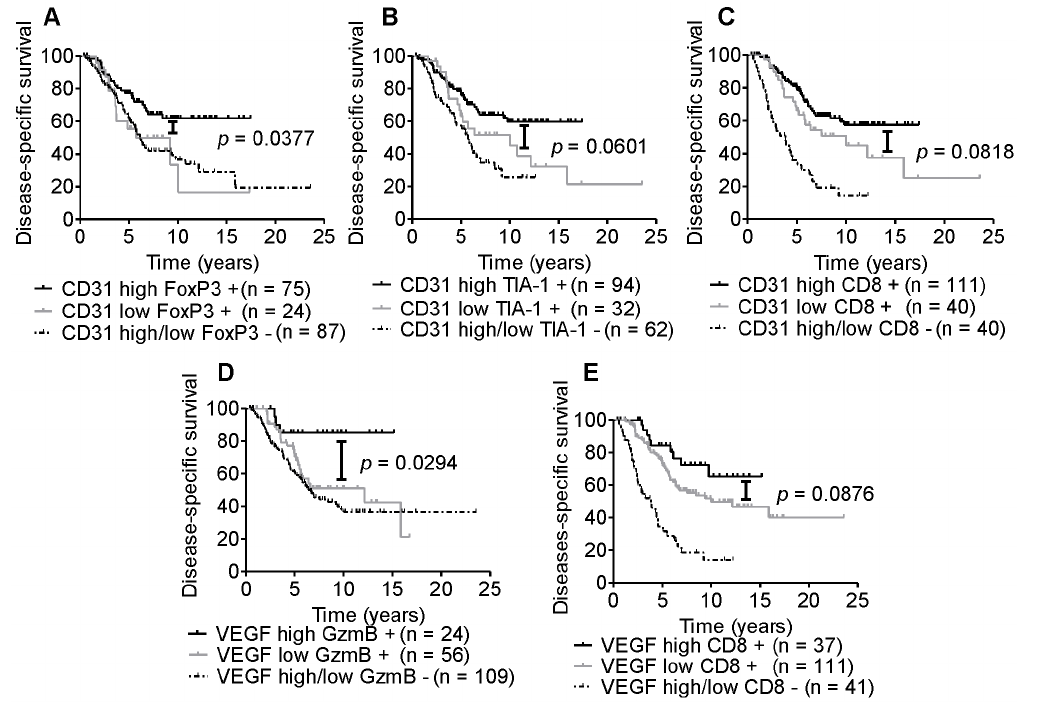
Figure 6. TIL and markers of immune function are associated with improved patient outcome. Kaplan-Meier analysis of disease-specific survival of high-grade serous ovarian carcinoma patients categorized by CD31, VEGF or the indicated immune markers: (A) CD31 and FoxP3, (B) CD31 and TIA-1, (C) CD31 and CD8, (D) VEGF and Granzyme B (GzmB), (E) VEGF and CD8. The statistical significance was determined using a log-rank test.